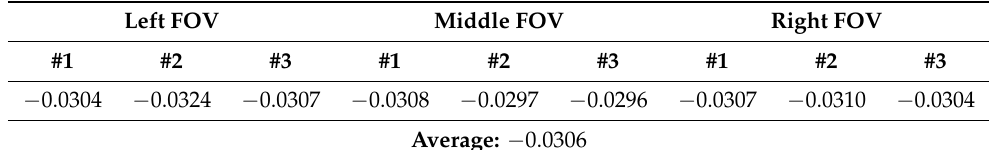
Table 6. The results of LSM detection on hyperspectral data acquired by